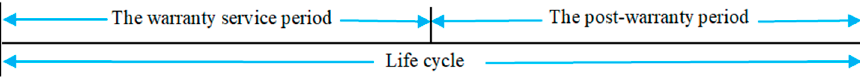
Figure 2. Life cycle description.